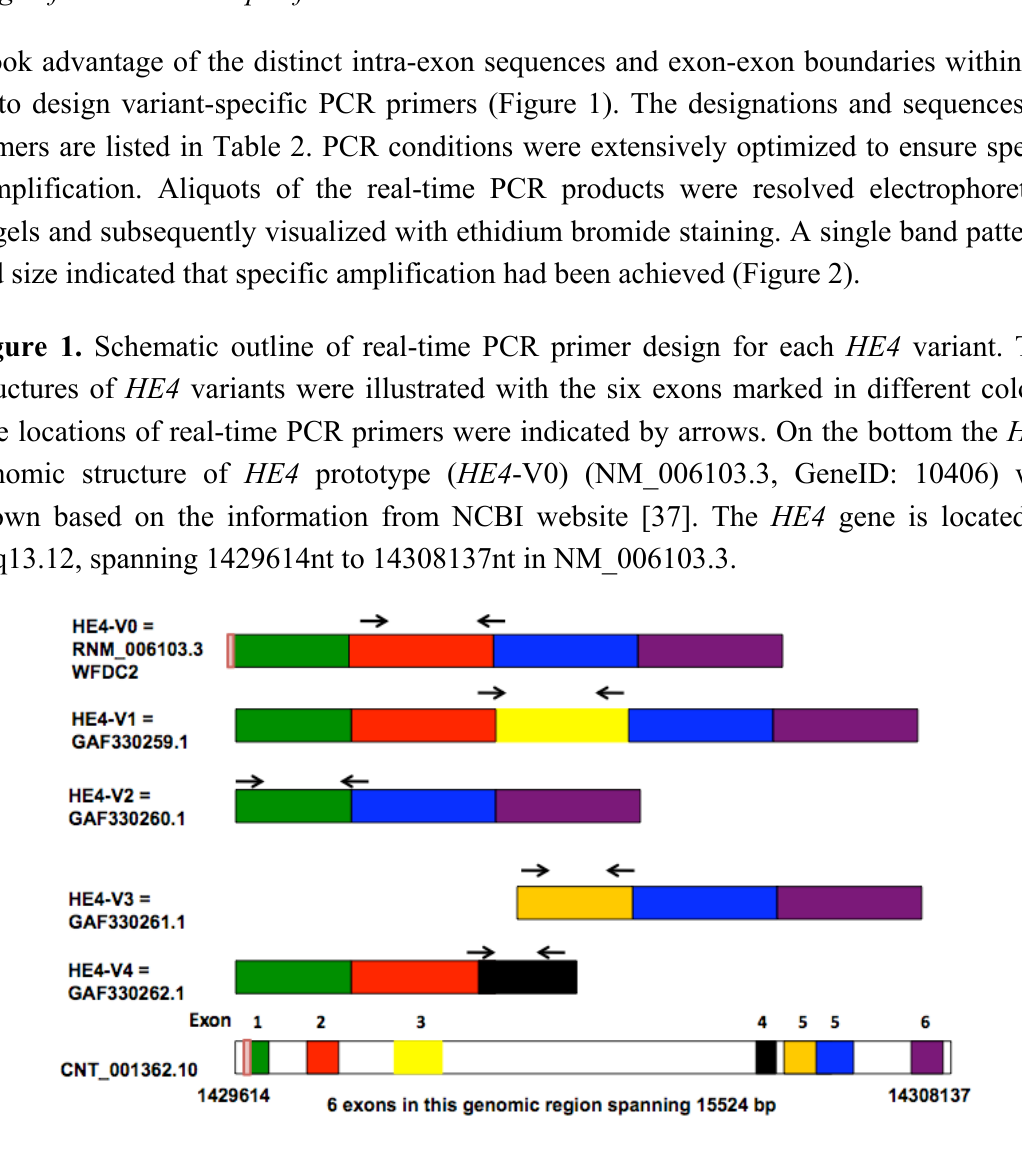
Table 2. Real-time PCR primers for HE4 transcript variants. The sequences and designation of PCR primers for real-time PCR measurement of HE4 transcript variant were